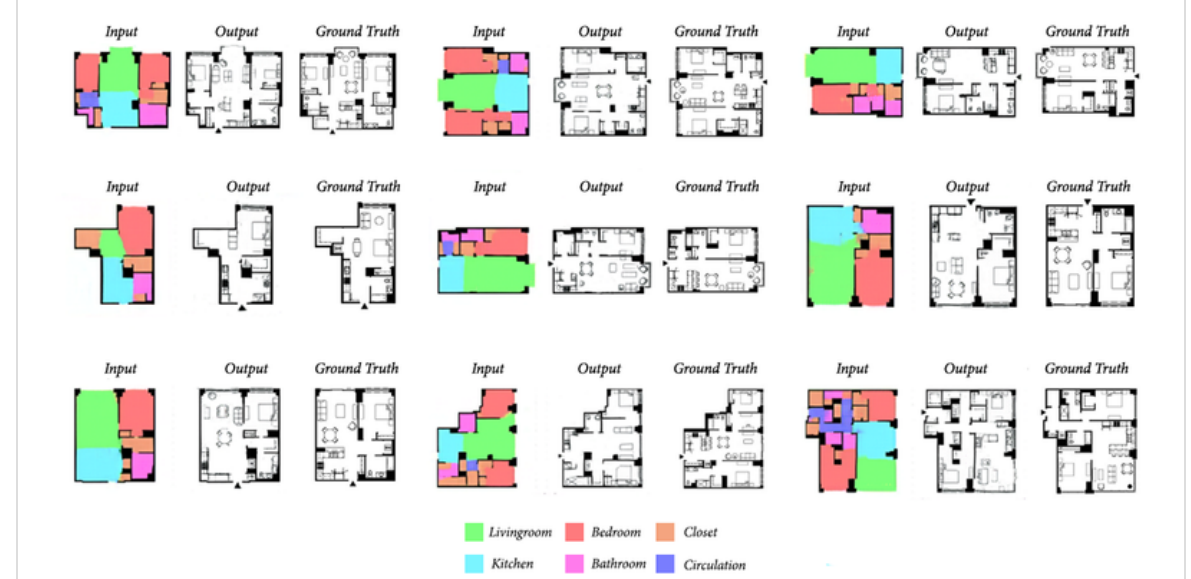
Figure 7. Sequential application of the neural network: Three stages . We can see the initial input from the designer as a generic geo-referenced plot (7a), the final output generated by the GAN (7b), and its ground truth (7c): the original floor plan used to train the network (this process is applied to all plans in the set). Output floor plans and ground truth are often compared to evaluate the similarity between the computer generated and the original